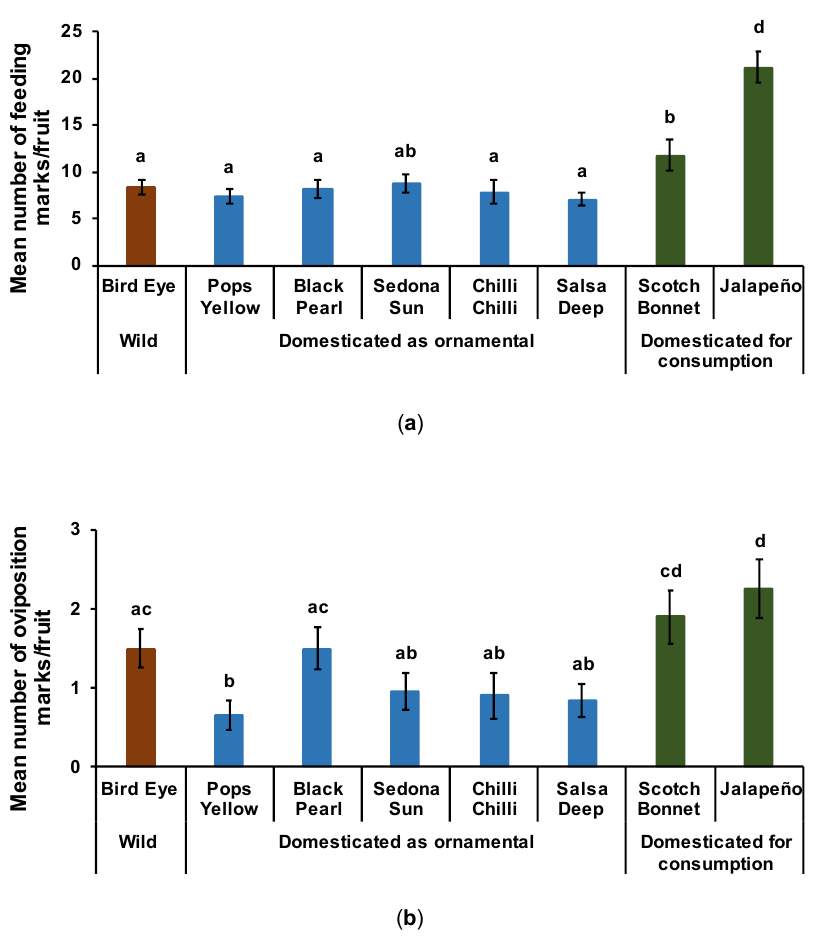
Figure 4. Infestation by pepper weevil on ornamental and domesticated peppers showing the mean number of feeding holes per fruit ( a ) and the oviposition marks per fruit ( b ). No-choice tests using two fruits per Petri dish. The differences among treatments are indicated by different letters (F-test, Tukey ’s post-hoc test with Bonferroni correction: p < 0.001, N = 20).